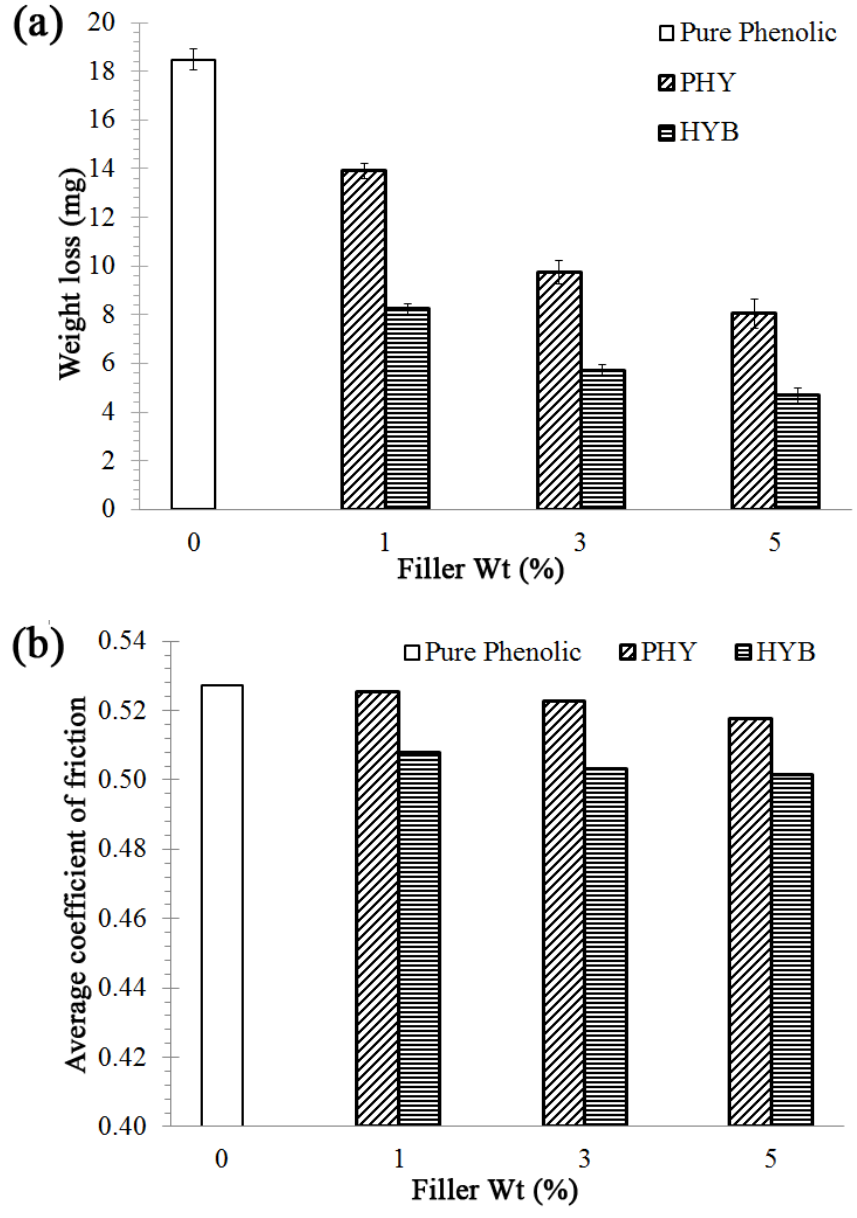
Figure 3. Properties of the HYB composite and PHY composite as a function of filler loading at 0.033 m/s sliding speed and 10 N applied load: ( a ) weight loss; ( b ) average coefficient of friction.